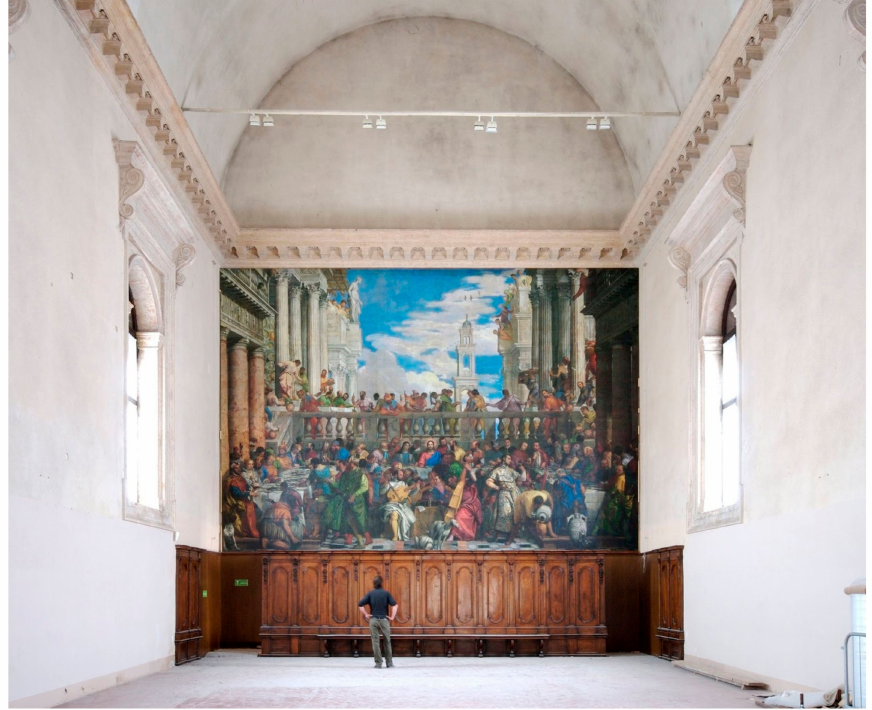
Figure 16. The copy of Paolo Veronese’s “Le Nozze di Cana” realized by Factum Arte and installed in the ancient original place from which it was taken away. (source: http://www.accademiadegliincerti. it/originale-copia-e-riproduzione/, accessed on the 8th of April